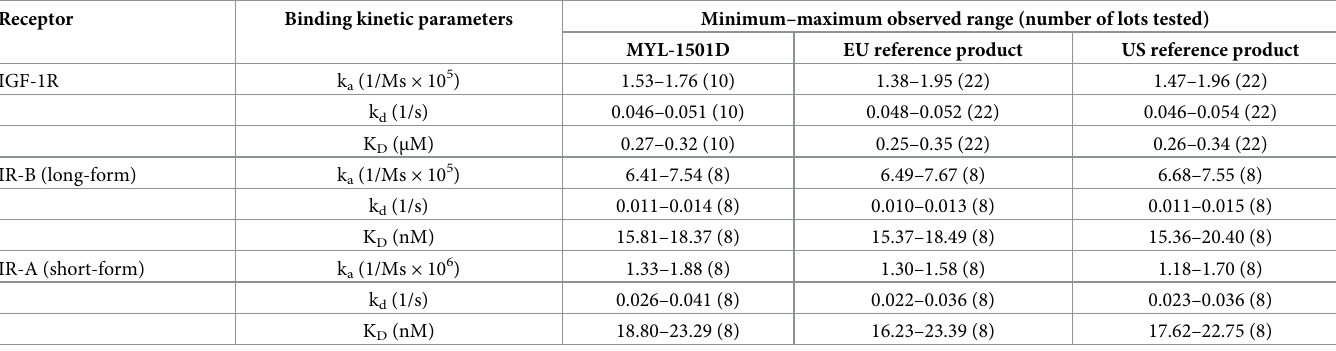
Table 3. Insulin receptor IR-A, IR-B and IGF-1R, binding kinetics of MYL-1501D, US- and EU-licensed insulin glargine.